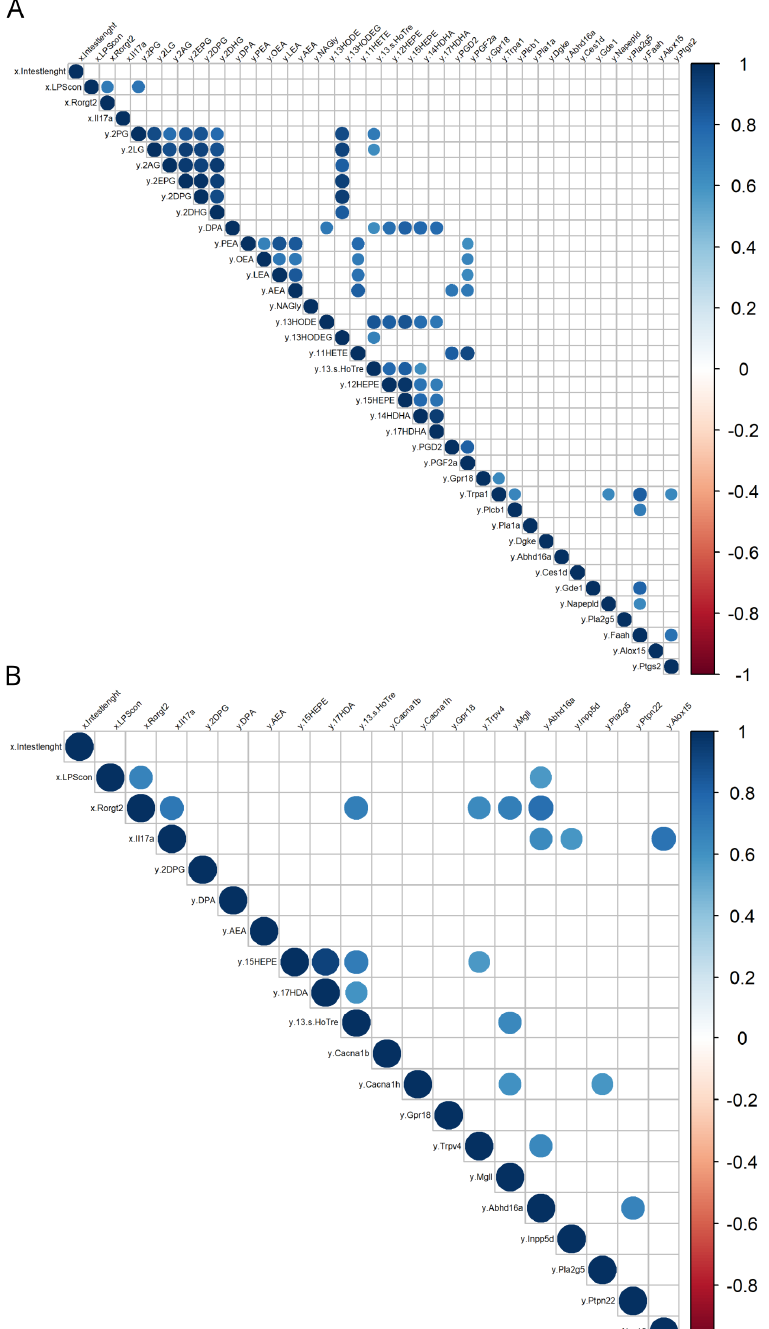
Figure 5. Correlation plot between intestinal length, bacterial components, mRNAs of inflammatory markers, and the eCBome-related mediators measured in two gut segments (i.e., the duodenum and distal colon). ( A ) Correlation matrix showing Pearson correlations with Bonferroni’s adjustment in the duodenum; ( B ) Correlation matrix showing Pearson correlations with Bonferroni’s adjustment in the colon. Positive correlations are displayed in blue and negative correlations in red. Color intensity and size of the circles are proportional to the correlation coefficients. “x” refers to the first data set, the intestinal length, bacterial components, and inflammatory markers, while “y” refers to the second data set, the eCBome-related mediators and mRNAs measured in the two respective gut